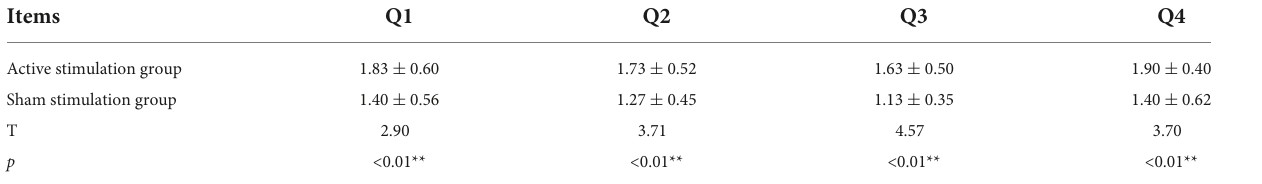
TABLE 5 Subjective Perception of Experimental Procedures